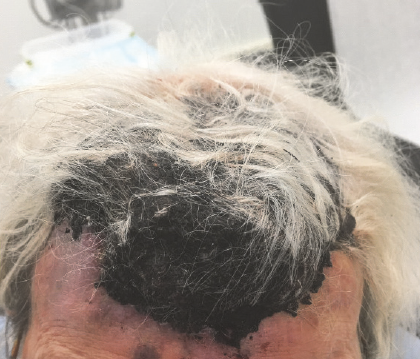
Figure 1: A bluish-violaceous discoloration is seen under her scalp.